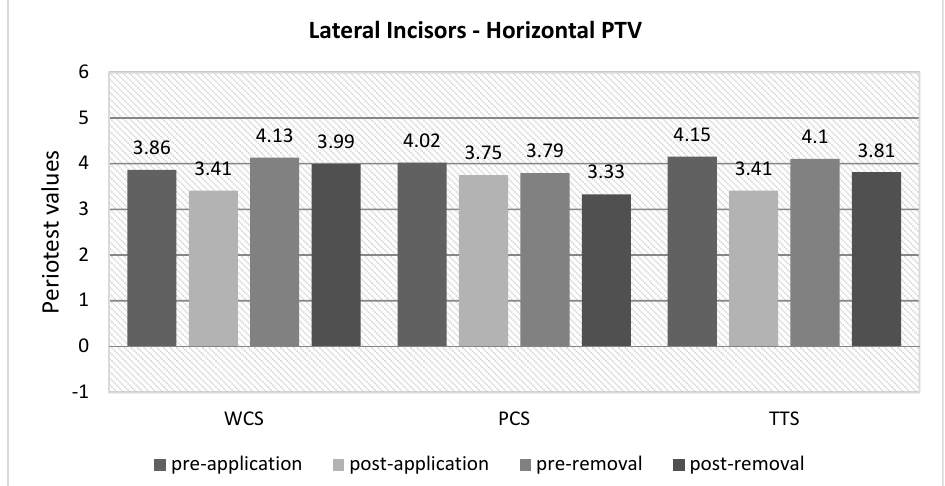
Figure 6. Horizontal Periotest values for lateral incisors.